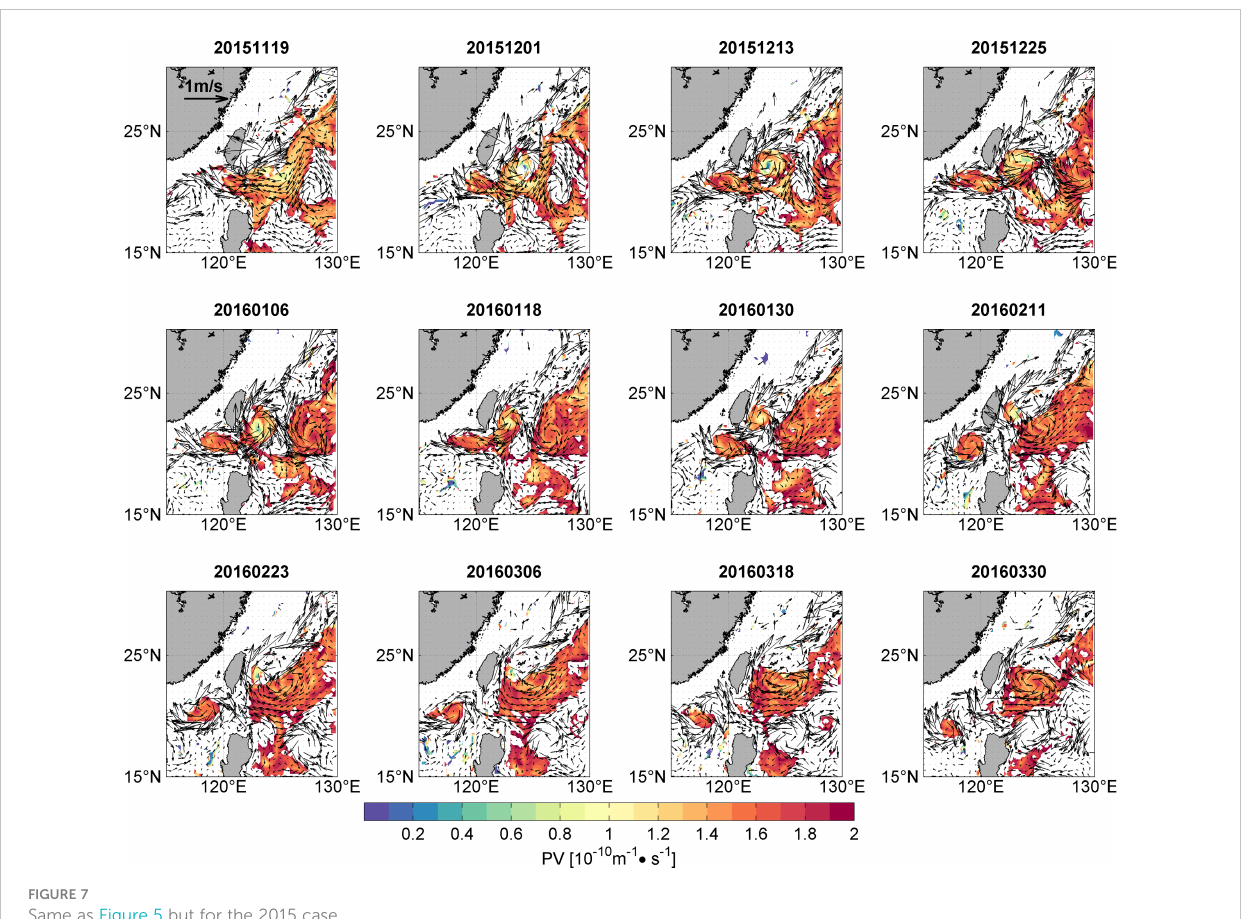
FIGURE 7 Same as Figure 5 but for the 2015